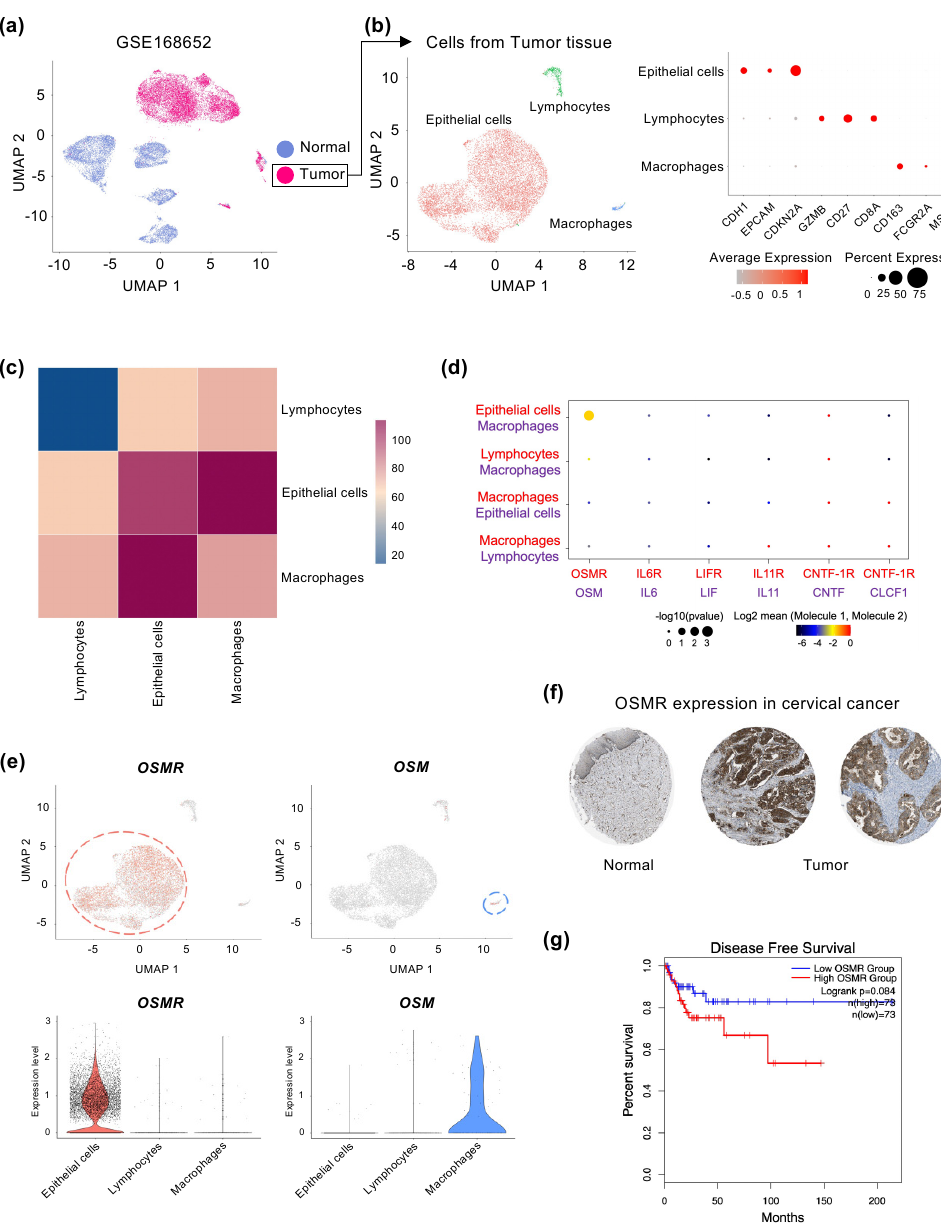
Figure 1. OSM–OSMR interactions are shown between epithelial cells and macrophages in the cervix tumor environment. ( a ) UMAP plots of scRNA-seq data (GSE168652) for normal and tumor tissue cells from human cervical cancer. ( b ) UMAP projection of cervix tumor tissue that were subgrouped by re-clustering analysis of scRNA-seq data. Dot plot of mean expression values of markers by cell type for epithelial cells, lymphocytes, and macrophages. ( c ) A heatmap that describes the frequency of cell-to-cell communication of the three cell types. The color of each grid represents a cell–cell interaction score. ( d ) Ligand–receptor interactions detected for the IL-6 family receptors (red) and ligands (purple) and between the different cell types. The size of the circle represents the p -value. The color of the circle demonstrates the mean value of cell–cell interaction. ( e ) Feature and violin plots displaying OSMR and OSM expression in cervix tumor tissue cells. ( f ) OSMR protein was upregulated in tumor tissue compared with normal cervix tissue according to The Human Protein Atlas database. ( g ) Kaplan–Meier curves showing disease-free survival for cervical SCCs with high vs low expression of OSMR , determined from the GEPIA2